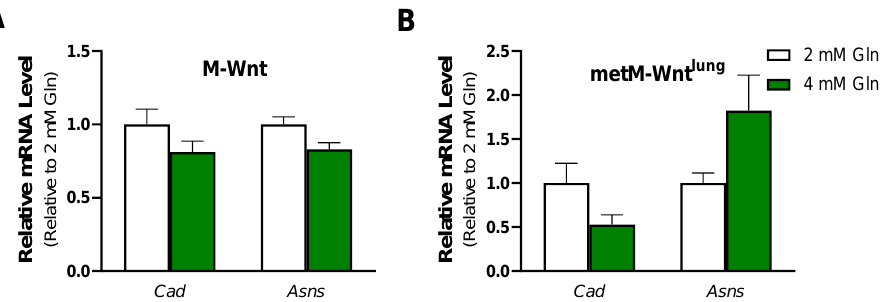
Figure 4. Effect of glutamine concentration on ammonium detoxification genes. Relative mRNA level of carbamoyl-phosphate synthetase 2 (Cad) and asparagine synthetase (Asns) was determined by qRT-PCR in ( A ) M-Wnt and ( B ) metM-Wnt lung cells grown in 2 or 4 mM glutamine.